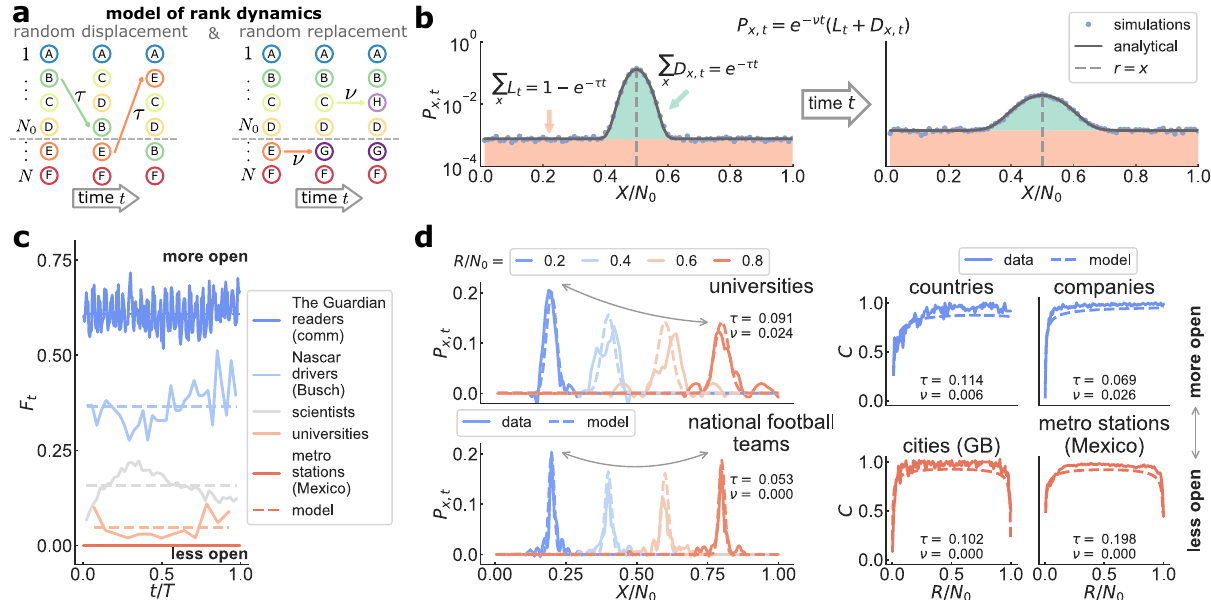
Fig. 2 Model of rank dynamics reproduces features of real-world ranking lists. a Model of rank dynamics in a system of N elements and ranking list size N t , a random element is moved to a random rank with probability τ . A random element is also replaced by a new element with probability ν . 0 . At time b Probability P x , t that element in rank r = R / N moves to x = X / N after time t (uppercase/lowercase symbols are integer/normalized ranks). Elements not replaced diffuse around x = r (with probability D x , t ) or perform Lévy walks 55 (with probability L t ). Eq. (2) recovers simulation results, shown here for τ = 0.1, ν = 0.2, N = 100, and N = 80 at times t = 1, 5 (left/right plots), averaged over 10 5 realizations. c Time series of rank fl ux F 0 data (lines), and mean fl ux F from the fi tted model (dashes) (all datasets in SI Fig. S3; for fi tting see SI Section S5). d Probability P x , t for t = 1 and varying r (left) and rank change C (right), shown for selected datasets (lines) and fi tted model (dashes; τ and ν in the plot) (empirical P Savitzky – Golay smoothing fi lter; see SI Figs. S6 – S9 and SI Table S2). As systems become more open, we lose symmetry in the rank dependence of both C and the height of the diffusion peaks of P x , t (signaled by curved arrows). Data and model have similar qualitative behavior in all rank measures (for a systematic comparison see SI Fig.